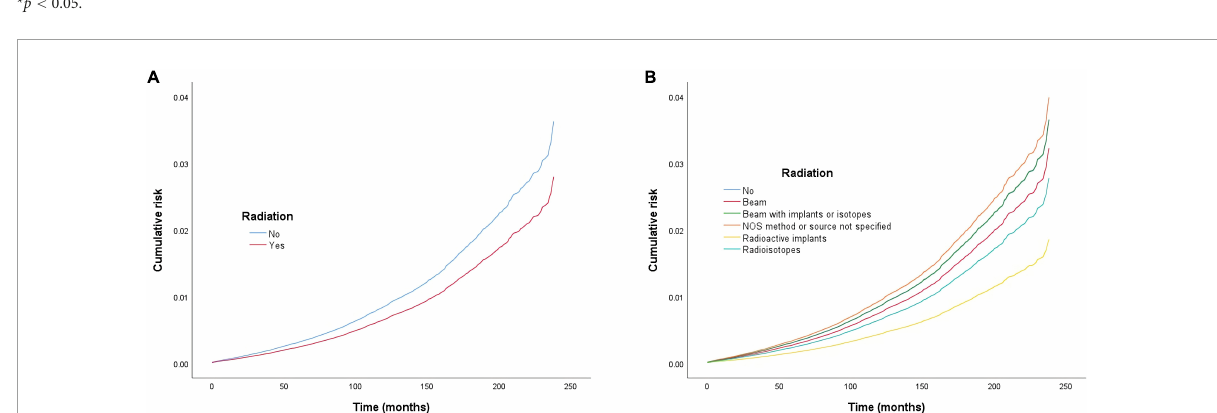
White ethnicity, non-Hispanic ancestry, female sex, marital status, and middle-income. About 44% of patients received various types of RT, the vast majority of patients received surgery, and very few patients were treated by